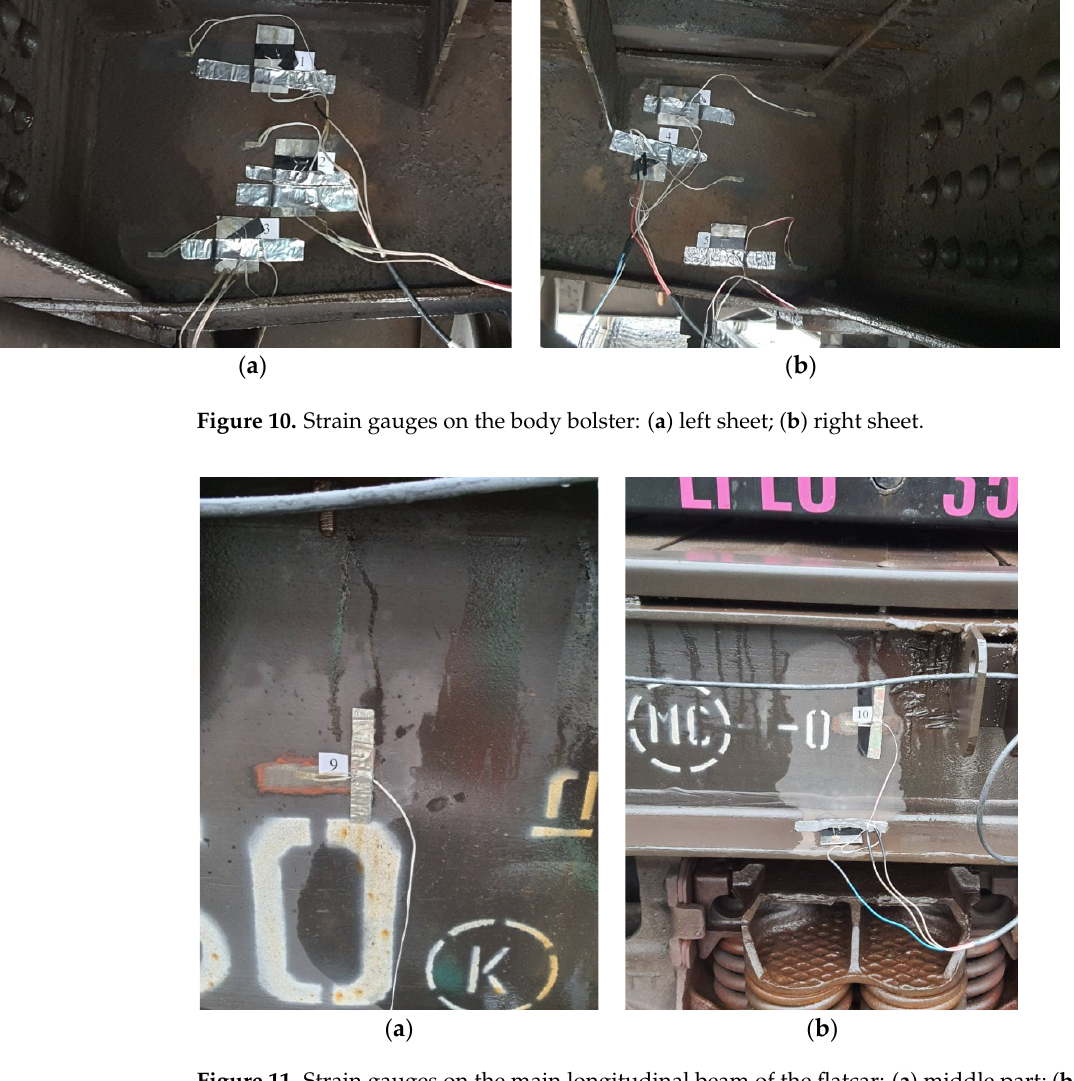
Figure 9. Strain gauges connected. The position of the strain gauges is shown in Figures 10–12.